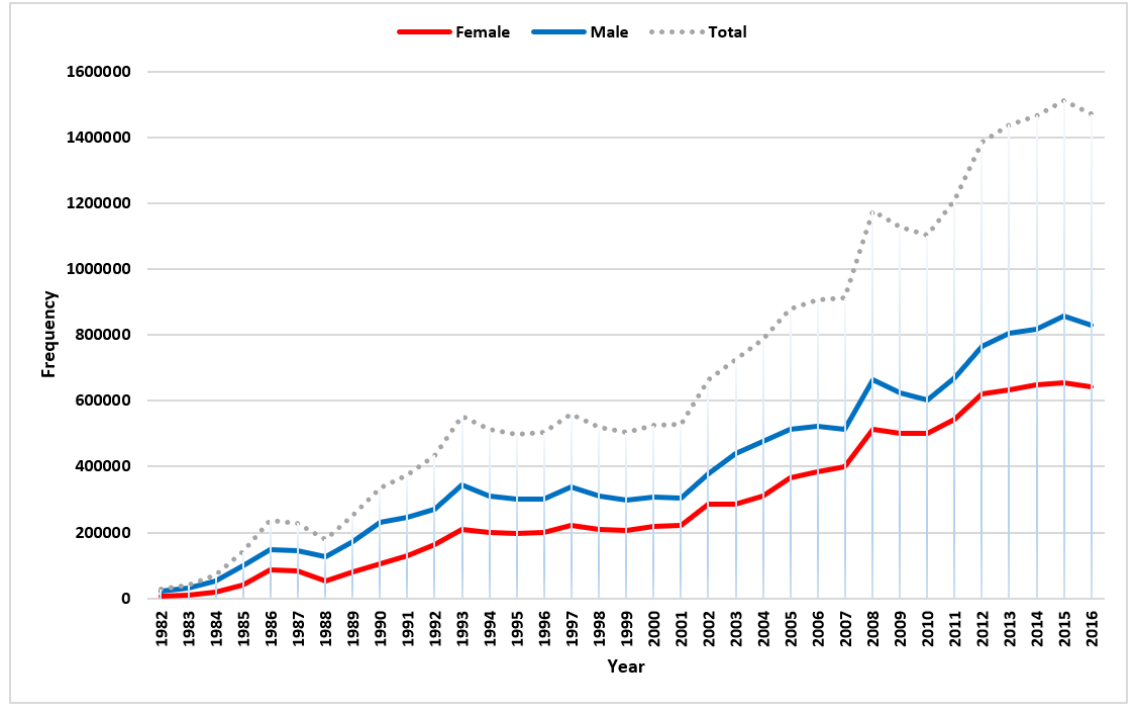
Figure 3. The number of active male and female student numbers